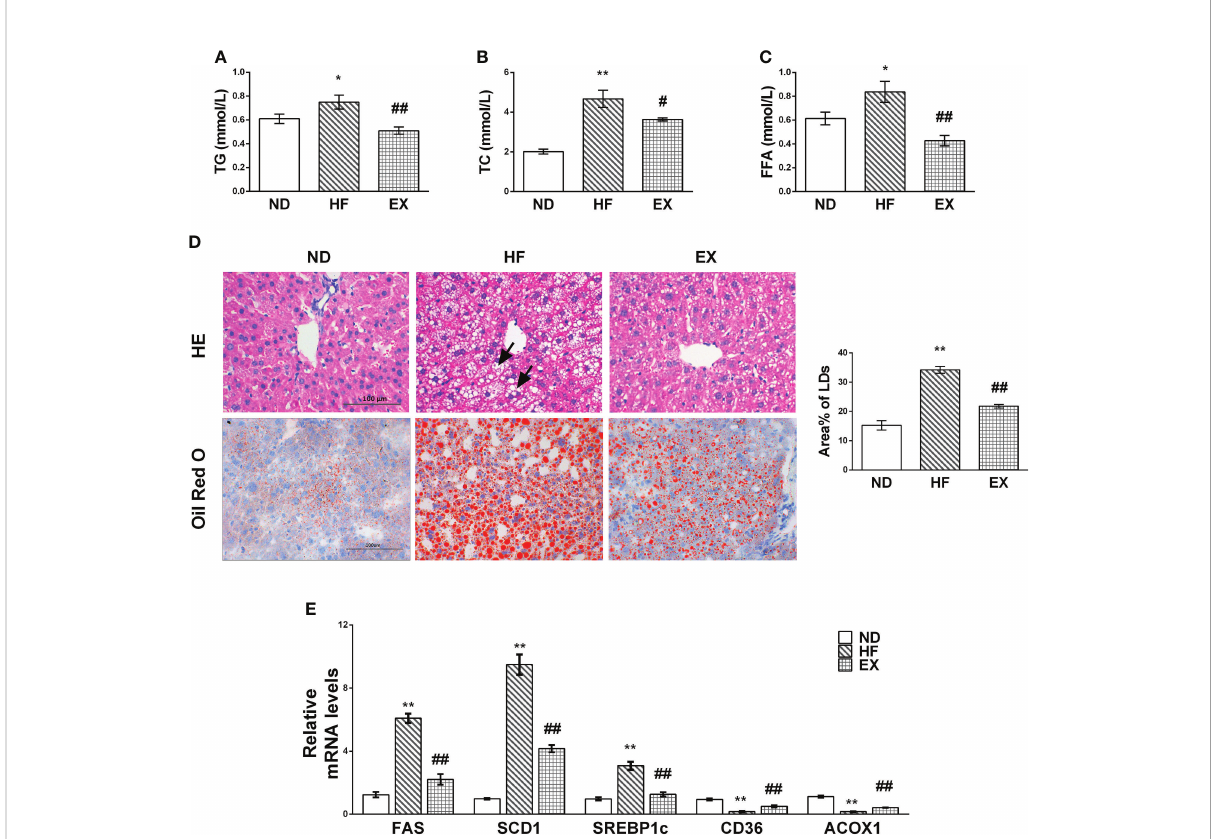
FIGURE 1 Mice with exercise training show improved lipid metabolism in serum and liver tissue samples. Male C57BL/6J mice were fed with a normal diet (ND) or a high-fat diet with (EX)/without (HF) swimming training for 4 months. Serum TG (A) , TC (B) , and FFA (C) levels were assessed ( n = 5 per group). Representative images of liver sections at 400× magni fi cation stained with HE ( n = 3 per group), Oil Red O ( n = 5 per group), and the average LD areas stained by Oil Red O (D) . Black arrowheads indicate hepatocellular swelling. Hepatic mRNA expression of FAS, SCD1, SREBP- 1c, CD36, and ACOX1 by RT-PCR ( n = 5 per group) (E) . M ± SEM; * P < 0.05 versus ND; ** P < 0.01 versus ND; # P < 0.05 versus HF; ## P < 0.01 versus